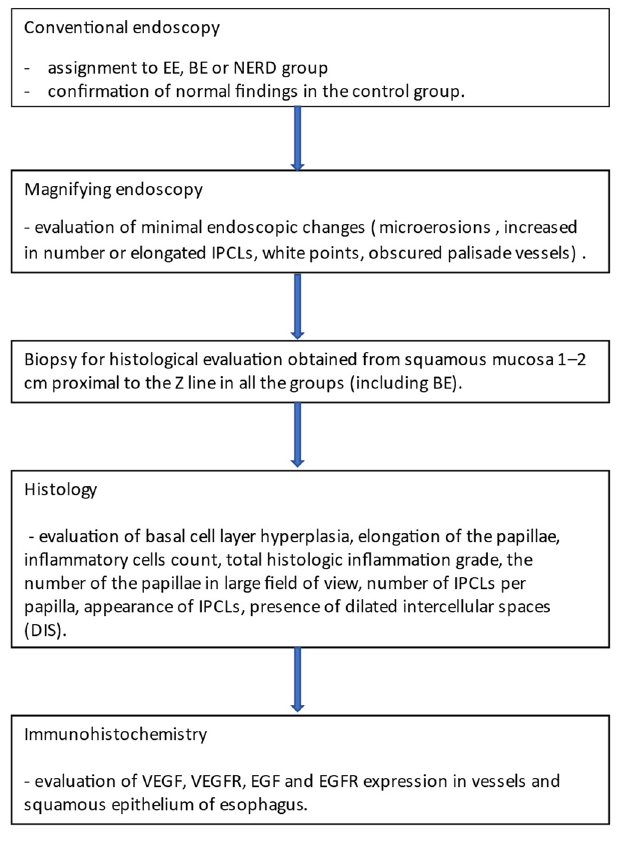
Figure 1. Study Figure 1. Study design.